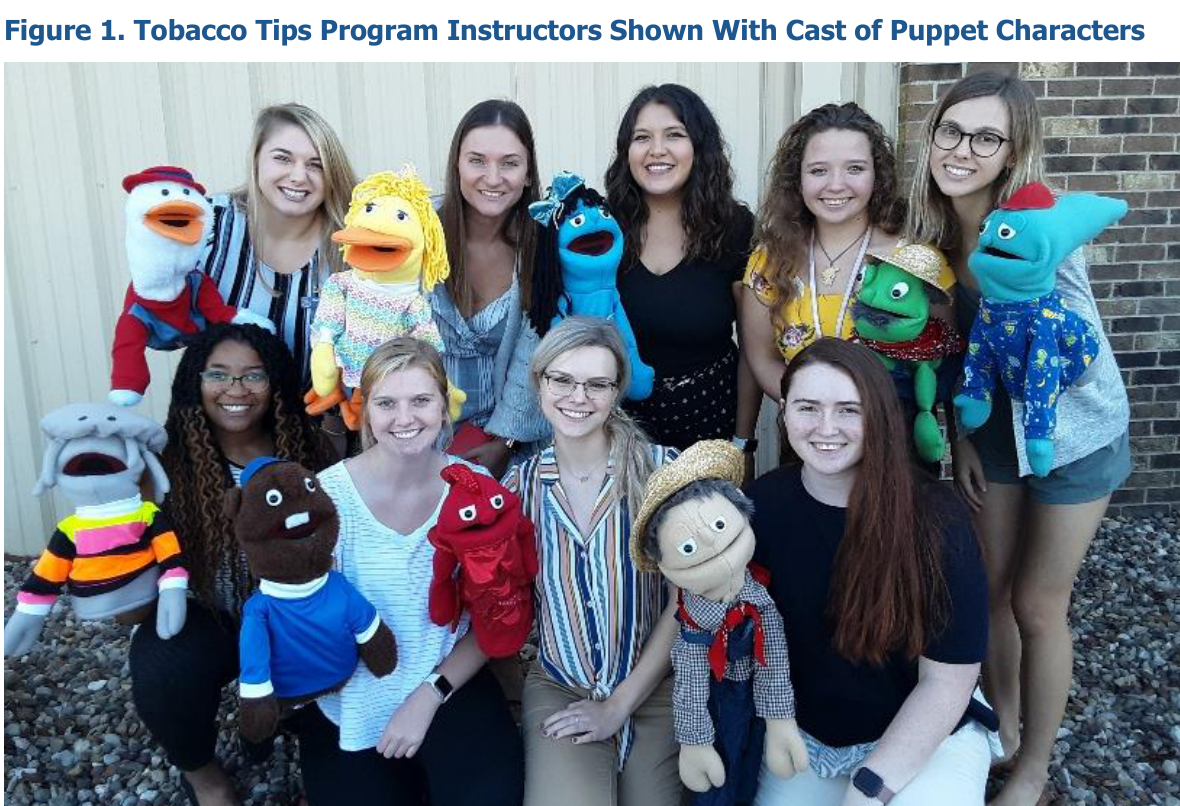
Back row, left to right: Handy Gander, Daisy Duck, Merry Mermaid, Bull Frog, and Freddie Fish. Front row, left to right: Tad Pole, Buddy Beaver, Clay-Ton Crab, and Arnold the